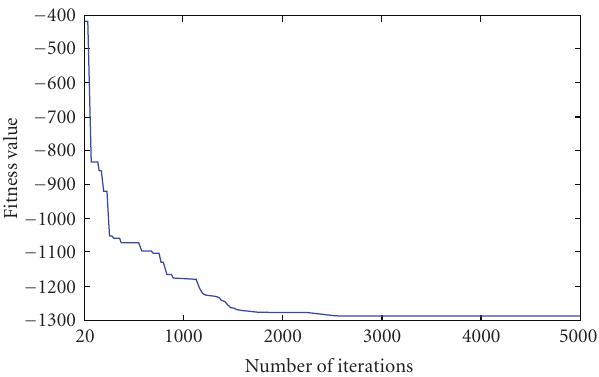
Figure 4: Convergence rate of the PSO algorithm, showing fitness value versus number of